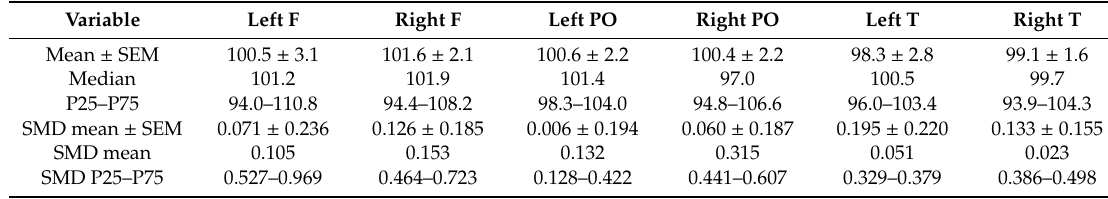
Table A10. Changes in spectral entropy during